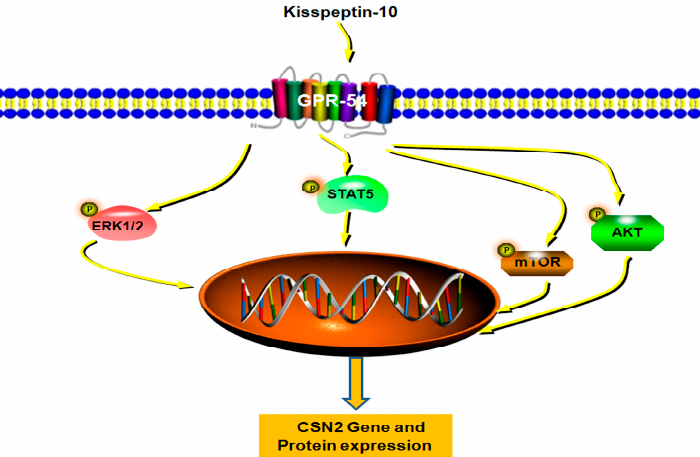
Figure 8. Schematic diagram of the proposed molecular mechanism for Kp-10 induce CSN2 gene and protein expression in bMECs. Kp-10 binds to GPR54 and this leads to the activation of mTOR, AKT, ERK1/2 and STAT5 signaling pathways. The increased effect of CSN2 synthesis is blocked when the cells were pre-treated with the selective inhibitor of GPR54. All the inhibitors of the four signaling pathways attenuate the Kp-10-induced expression of CSN2 in bMECs. Altogether, Kp-10 facilitates the synthesis of CSN2 via GPR54 and its downstream signaling pathways mTOR, ERK1/2, STAT5 and AKT.